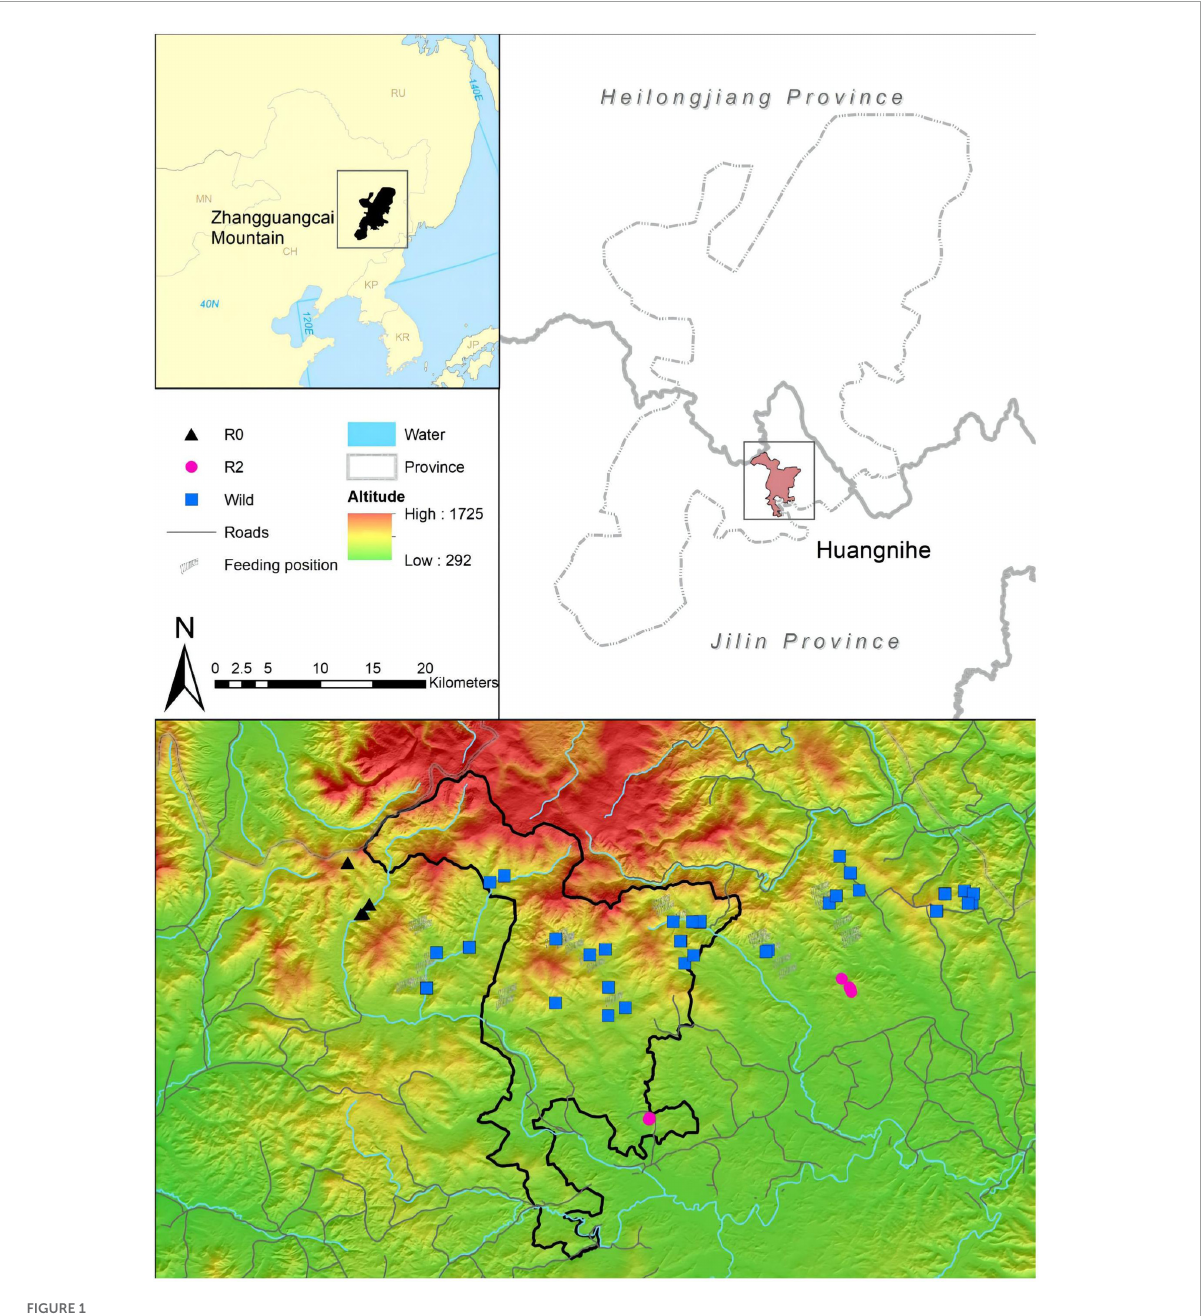
FIGURE1 A map showing the location of the individuals of the three groups; colors represent different groups.